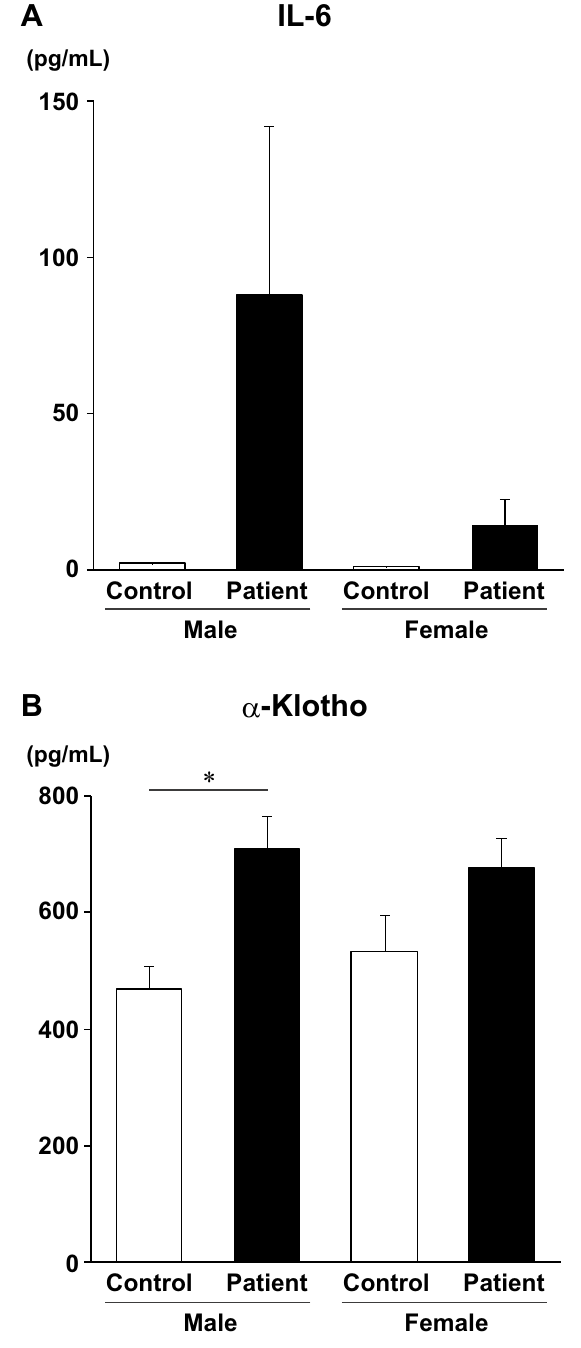
Figure 3. Serum IL-6 and α-Klotho levels in male and female patients. Serum IL-6 and α-Klotho levels were measured in healthy age-matched individuals (Control) and patients (Patient) with heart failure. Values are expressed as mean ± sem. White and black bars indicate controls and patients, respectively. *P = 0.0039. Non- repeated two-way analysis of variance (ANOVA) followed by Tukey’s post hoc test was